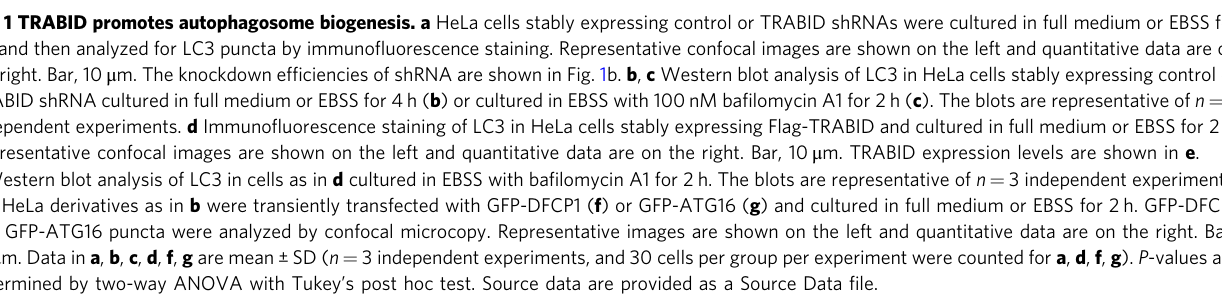
Fig. 1 TRABID promotes autophagosome biogenesis. a HeLa cells stably expressing control or TRABID shRNAs were cultured in full medium or EBSS for 2 h and then analyzed for LC3 puncta by immuno fl uorescence staining. Representative confocal images are shown on the left and quantitative data are on the right. Bar, 10 μ m. The knockdown ef fi ciencies of shRNA are shown in Fig. 1b. b , c Western blot analysis of LC3 in HeLa cells stably expressing control or TRABID shRNA cultured in full medium or EBSS for 4 h ( b ) or cultured in EBSS with 100 nM ba fi lomycin A1 for 2 h ( c ). The blots are representative of n = 3 independent experiments. d Immuno fl uorescence staining of LC3 in HeLa cells stably expressing Flag-TRABID and cultured in full medium or EBSS for 2 h. Representative confocal images are shown on the left and quantitative data are on the right. Bar, 10 μ m. TRABID expression levels are shown in e . e Western blot analysis of LC3 in cells as in d cultured in EBSS with ba fi lomycin A1 for 2 h. The blots are representative of n = 3 independent experiments. f , g HeLa derivatives as in b were transiently transfected with GFP-DFCP1 ( f ) or GFP-ATG16 ( g ) and cultured in full medium or EBSS for 2 h. GFP-DFCP1 and GFP-ATG16 puncta were analyzed by confocal microcopy. Representative images are shown on the left and quantitative data are on the right. Bar, 10 μ m. Data in a , b , c , d , f , g are mean ± SD ( n = 3 independent experiments, and 30 cells per group per experiment were counted for a , d , f , g ). P -values are determined by two-way ANOVA with Tukey ’ s post hoc test. Source data are provided as a Source Data fi